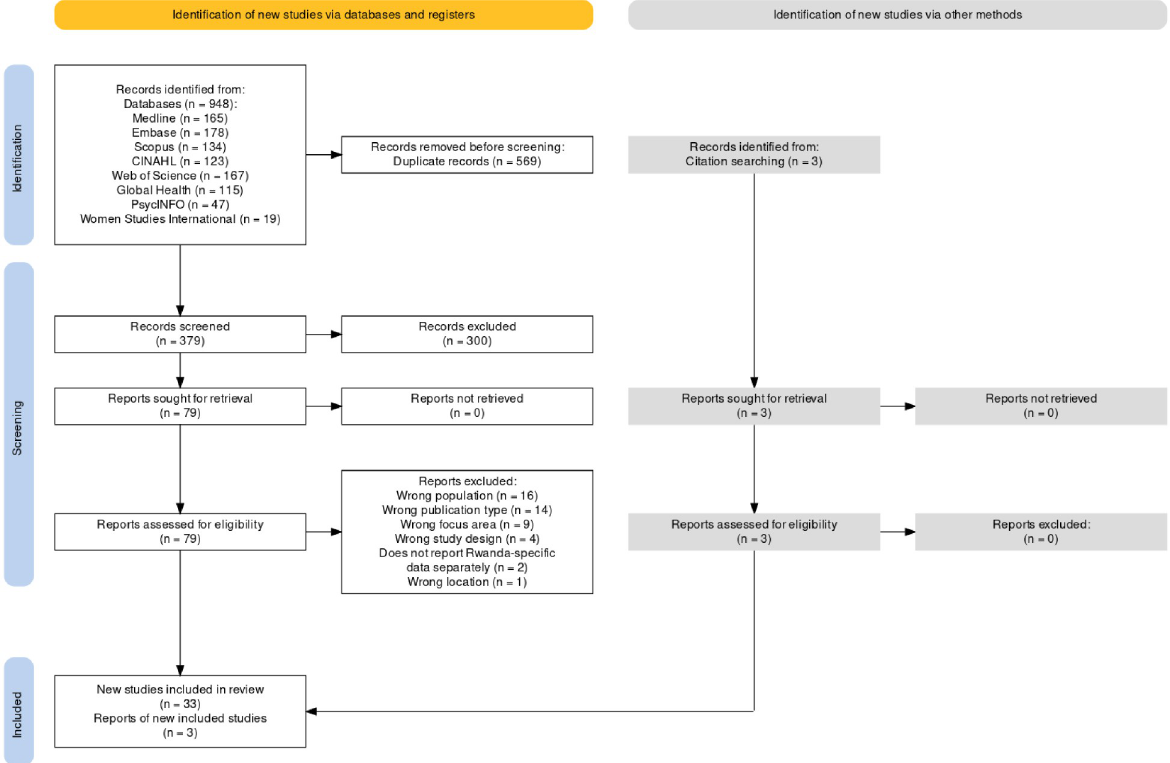
Fig 1. PRISMA flow diagram of articles screened for scoping review of qualitative studies of reproductive health across Rwanda, 2001–2021. https://doi.org/10.1371/journal.pone.0283833.g001 PLOS ONE | https://doi.org/10.1371/journal.pone.0283833 March 31,